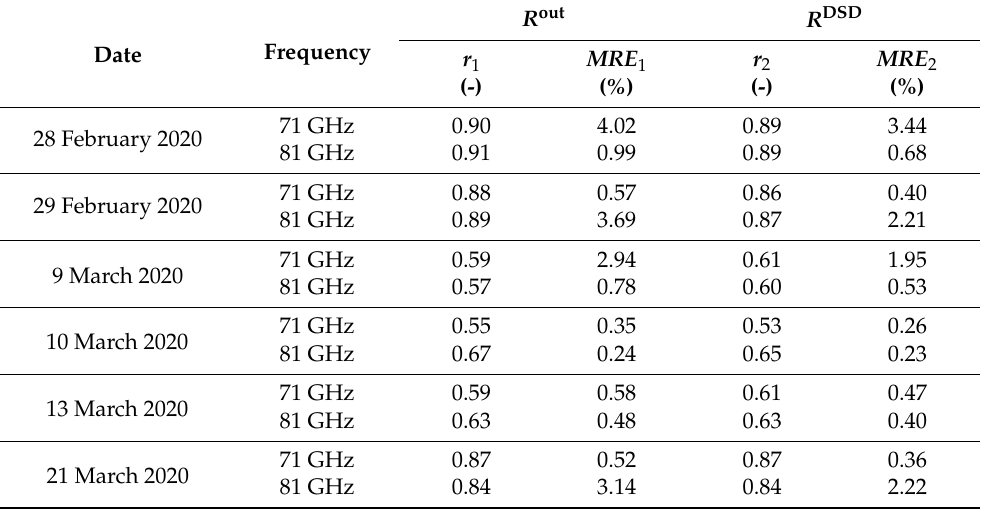
Table 4. Correlation ( r 1 and r 2 ) and mean relative error ( MRE 1 and MRE 2 ) of the estimated rainfall rate (based on the 71 and 81 GHz link) and the rainfall rate recorded by raindrop